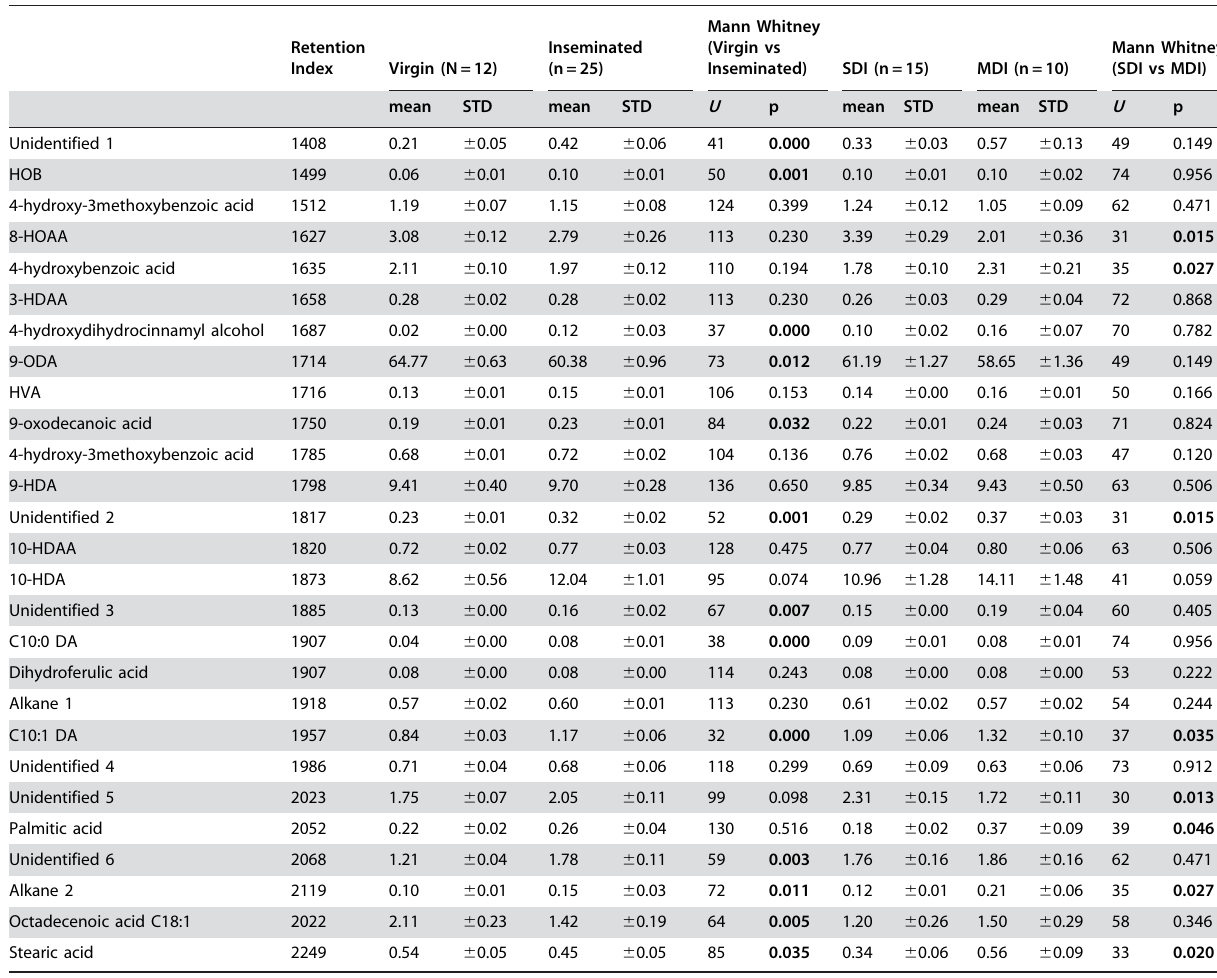
Table 2. Chemical identity and relative proportion (mean 6 STD) of the queen mandibular gland of honey bees Apis mellifera belonging to different queen group: virgin, single (SDI) and multi (MDI) drone inseminated queens. .. ... .... ... ... .... ... ... .... ... ... .... ... ... .... ... ... .... ... ... .... ... ... .... ... ... .... ... ... .... ... ... .... ... ... .... ... ... .... ... ... .... ... ...